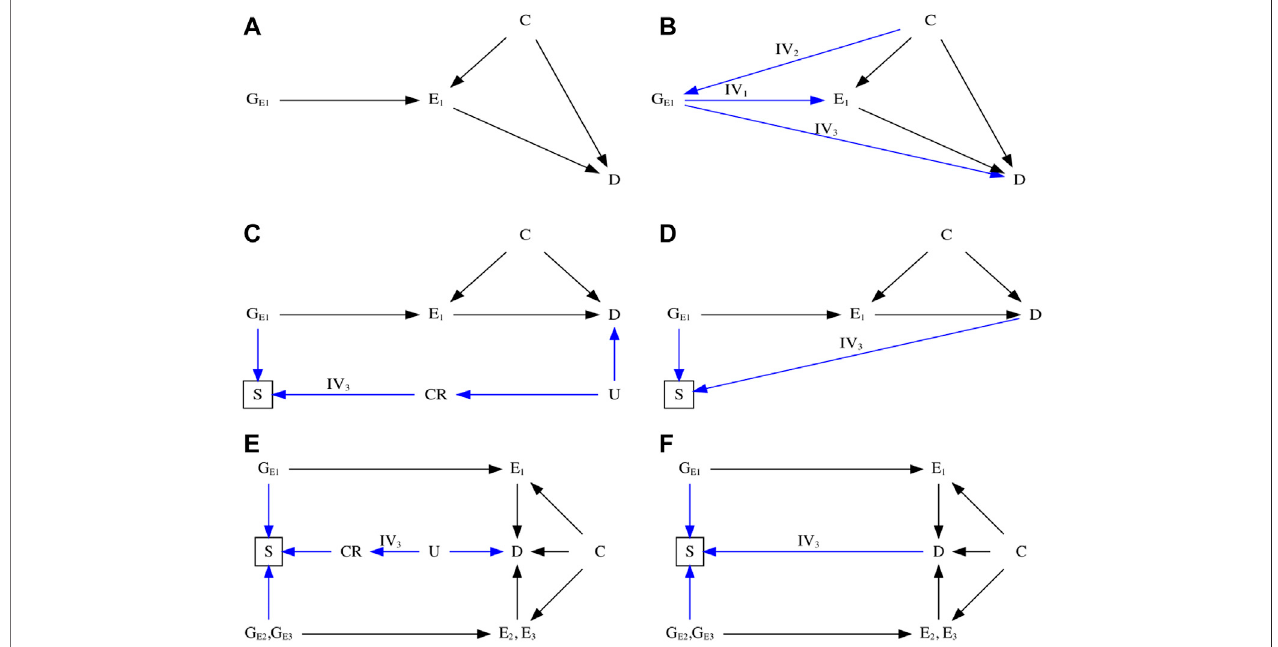
FIGURE 1 | Directed acyclic graph (DAG) illustrating Mendelian randomization (MR). (A) DAG illustrating an ideal scenario of an MR study. (B) DAG illustrating the three instrumental assumptions (Davey Smith and Ebrahim, 2003) — IV1: Relevance (Burgess et al., 2015); IV2: Independence (Burgess et al., 2012); IV3: Exclusion restriction. (C) DAGillustratingpotentialbiasedpathwaywithselectionbiasinthepresenceofcompetingrisksthatsharesubstantialetiologicalfactorswiththeoutcome. (D) DAGillustratingpotentialbiasedpathwaywithselectionbiasintheunrepresentativeselectedsamples. (E) DAGillustratinganMRstudyusingcontrolexposures to detect potential selection bias in the presence of competing risks. (F) DAG illustrating an MR study using control exposures to detect potential selection bias in the unrepresentativeselectedsamples.E 1 :theprimaryexposureofinterest;E 2 andE 3 :thecontrolexposures;C:theconfounderthatassociateswithboththeexposureand outcome; D: the outcome; CR: the competing risks; U: the unmeasured and shared confounders of the competing risks and the outcome; G E1 , G E2 , and G E3 : genetic variants that are strongly associated with the exposure of primary interest and the control